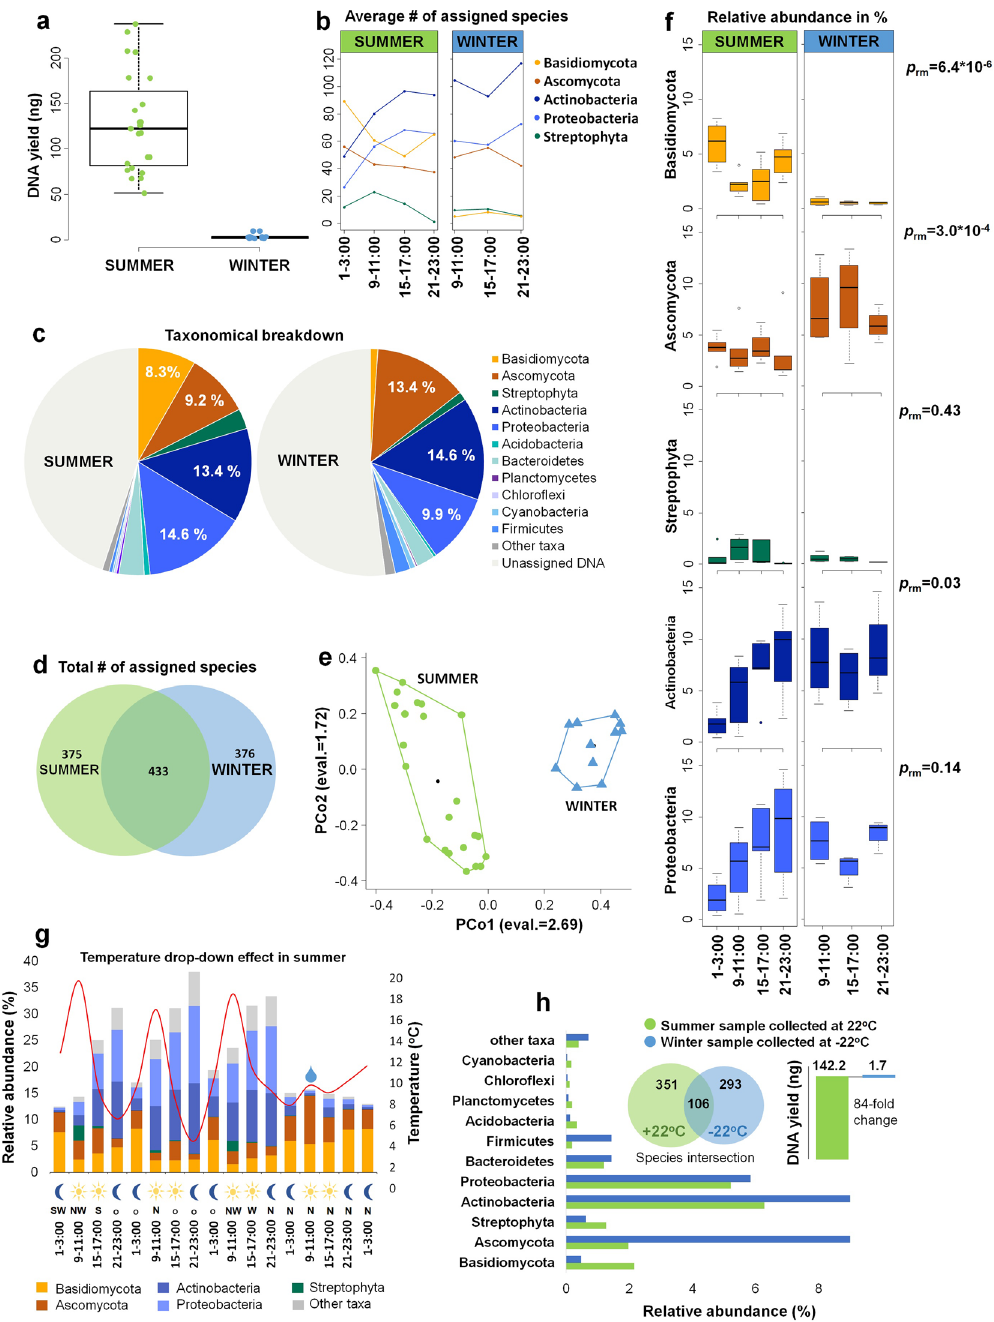
Figure 1. Seasonal dynamics of the airborne microbial communities. ( a ) Total DNA yields (in ng) isolated from the collected airborne biomass samples during the summer and winter time-series. ( b ) Richness of the summer and winter microbial communities with respect to the five most abundant taxa (Basidiomycota, Ascomycota, Actinobacteria, Proteobacteria, and Streptophyta). Airborne biomass samples were collected in different time intervals as indicated on the X axis. ( c ) Structure of the summer and winter microbial communities in maximal relative proportions of taxa. ( d ) Species intersection between summer and winter time-series. Values indicate the total number of identified species during summer and winter time-series. ( e ) Bray–Curtis dissimilarity distances between summer and winter samples plotted in the first two principal coordinates (PCo1 and PCo2). ( f ) Diel dynamics of the five most abundant airborne microbial taxa in summer and winter. P -values indicate significance of the differences in relative abundances between the 5 taxonomical groups in summer and winter time-series (regression modelling analysis). ( g ) Temperature drop-down effect in summer. Four consecutive days in summer 2018 time series are represented. Relative abundances (in %) of the five most abundant taxa are plotted. Red curve represents atmospheric temperature profile during the days of the experiment. Time scale is indicated at the bottom of the figure. Day and night samples denoted by sun and moon symbols. A rain event is indicated by the water drop-shaped symbol. Wind direction is indicated as follows: S—south, SW—southwest, NW—northwest, N—north, o—calm period. ( h ) Comparison of the summer and winter samples collected at + 22 °C and − 22 °C, respectively. Histogram represents relative abundances (in %) of taxa in both samples. Venn-diagram represents species intersection between the two samples. Absolute biomass load is presented via DNA yield (in